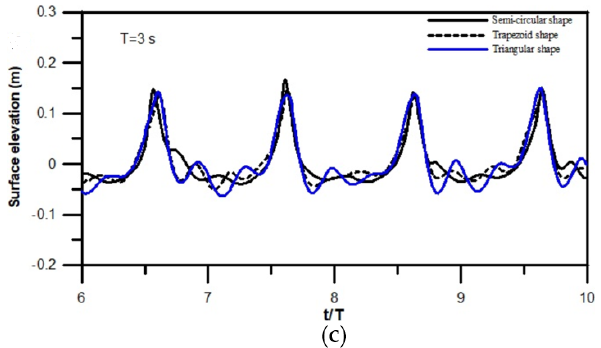
Figure 11. Time history of surface elevation with the incident wave height H i = 0.2 m and period T = 3 s at three wave gauges for the three types of breakwaters at the downstream distance ( a ) x = 18 m; ( b ) x = 20 m; ( c ) x = 22 m.